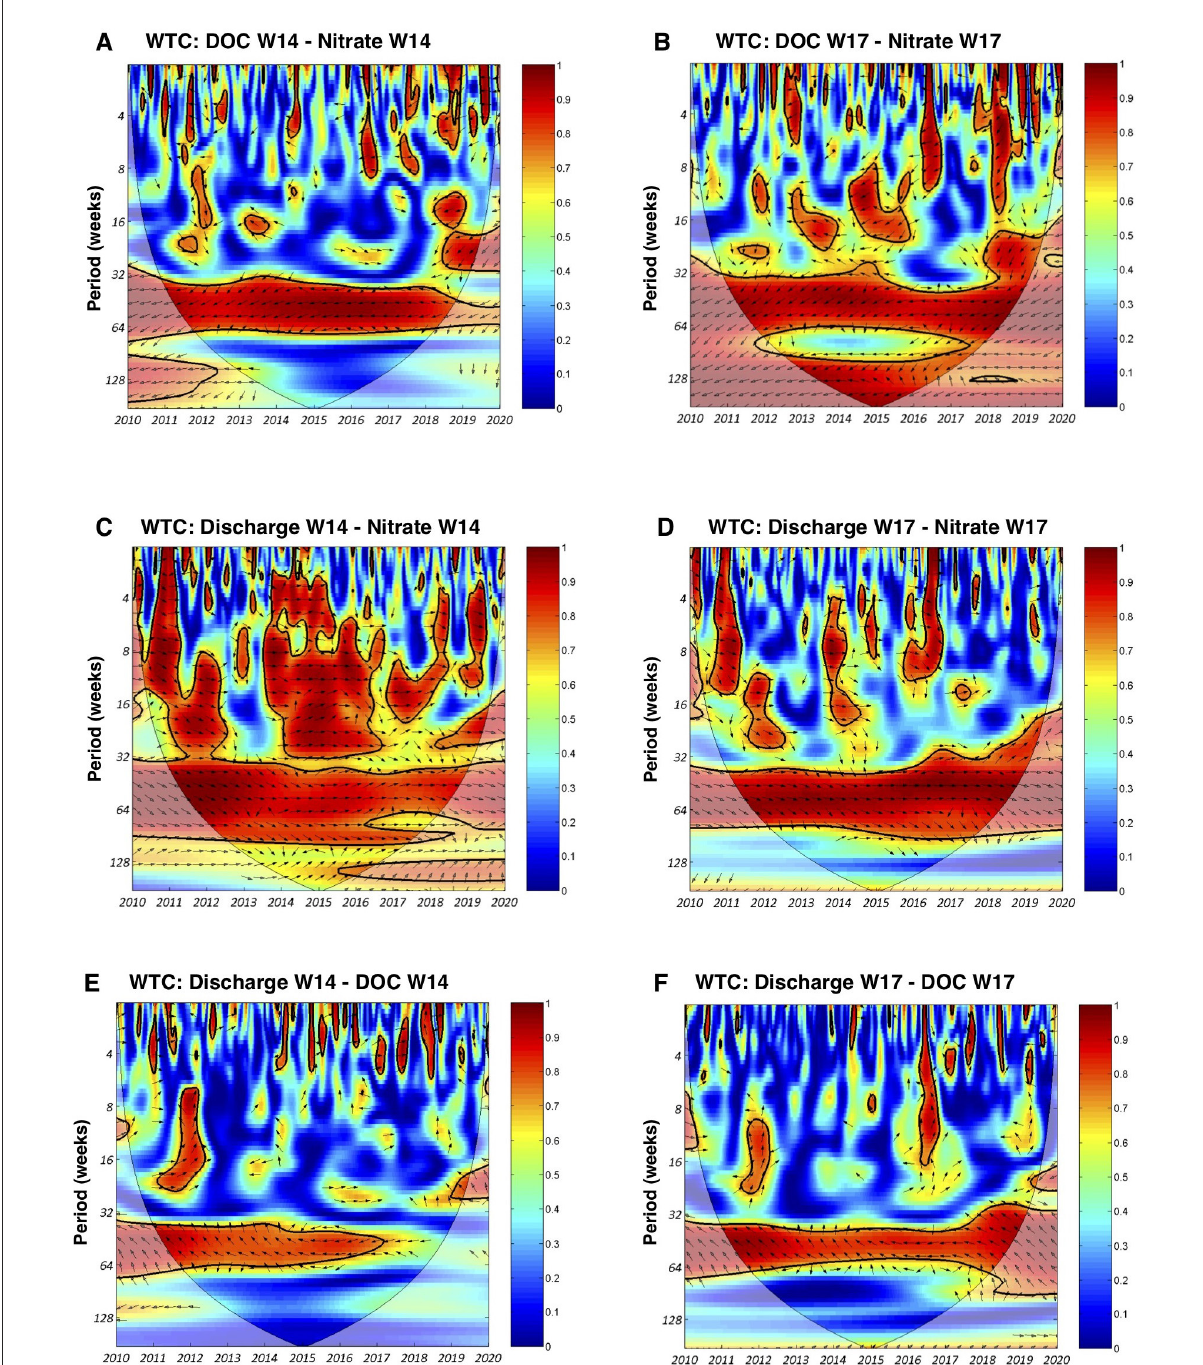
FIGURE6 WTC plots indicating the relationship between DOC and nitrate (A,B) , discharge and nitrate (C,D) , discharge and DOC (E,F) in the main outlet of the deforested Wüstebach catchment (W14) and the reference catchment (W17). The deforestation occurred in early September 2013.